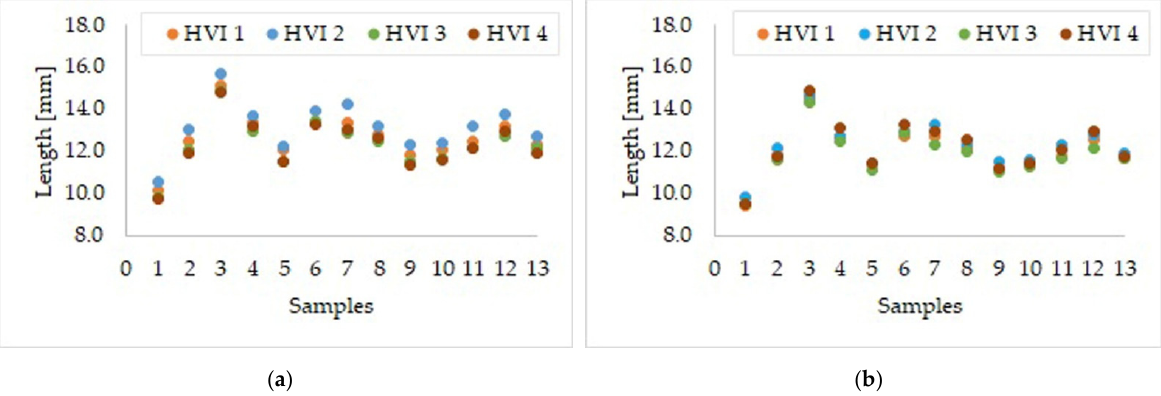
Figure 9. 25% SL of HVI fibrograms across 13 USDA commercial samples: ( a ) uncorrected, ( b ) corrected.